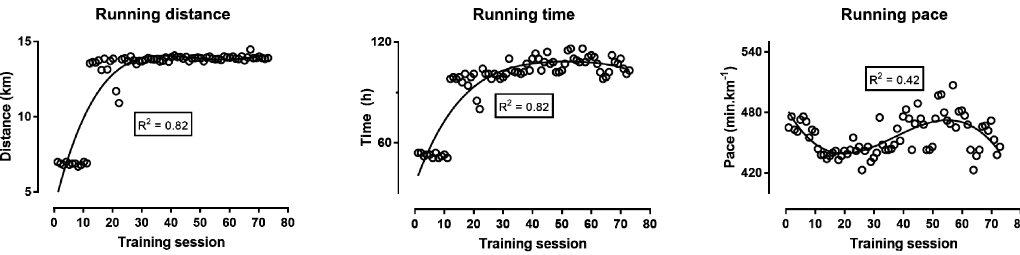
Figure 1. Training characteristics (i.e., running distance, time, and speed per training session) during the preparation for a 48-hour ultra-marathon.